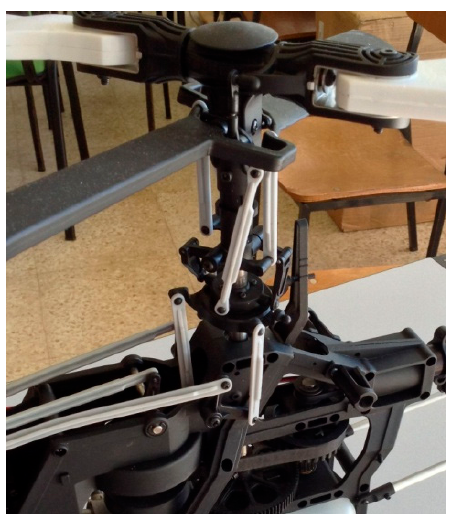
Figure 1. Propeller-driven propulsion system for an unmanned helicopter.